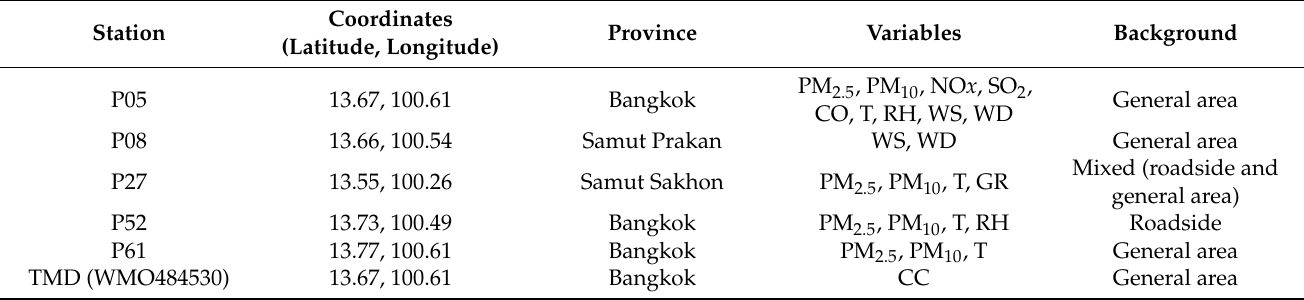
Table 1. Surface stations and variables used in the study.